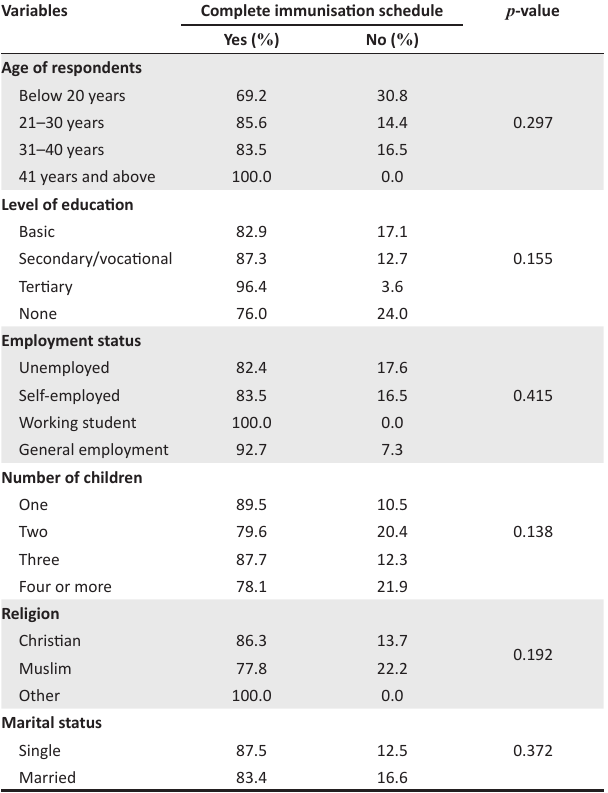
TABLE 3: Results of bivariate analysis of socio-demographic factors influencing immunisation of children. Variables